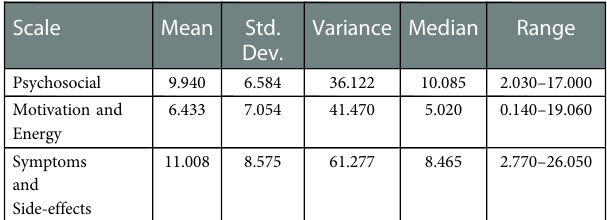
Table 9 RMSE and MAE scores for each scale on longitudinal